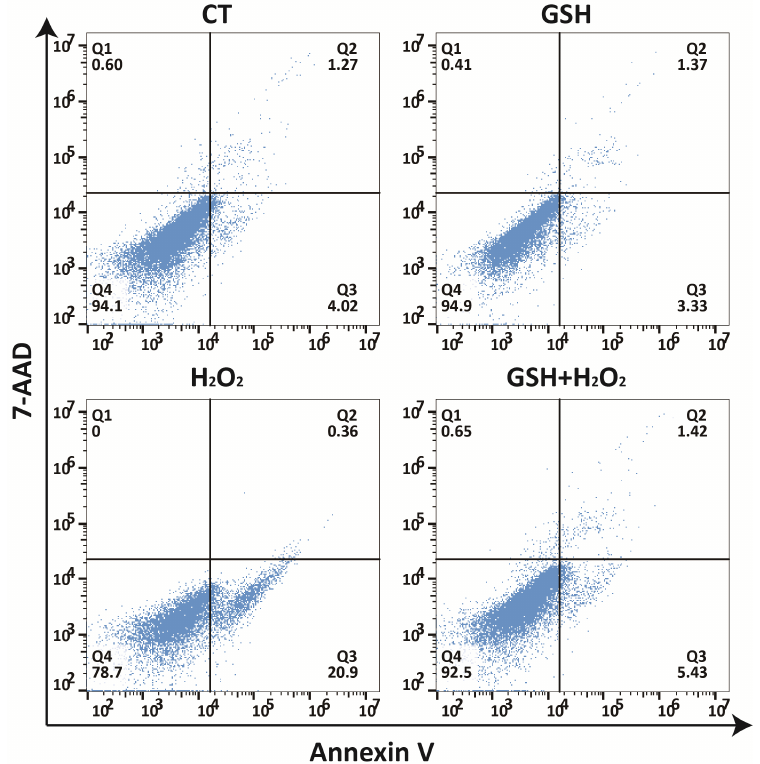
Figure 5. Protective effects of GSH against H 2 O 2 -induced apoptosis in IPEC-J2 cells . Cells were pretreated with or without H 2 O 2 (500 µ M) for 24 h. Afterwards, the culture medium was removed replaced with fresh medium with or without GSH (1.6 mM) and incubated for another 24 h, and cell distribution was analyzed using Annexin V-PE binding and 7-AAD uptake. The PE and 7-AAD fluorescence intensity were measured by flow cytometry using the FL-2 and FL-3 filters, respectively. Q4, living cells (Annexin V-/7-AAD-); Q3, early apoptotic/primary apoptotic cells (Annexin V + /7- AAD-); Q2, late apoptotic/necrotic cells (Annexin V + /7-AAD +